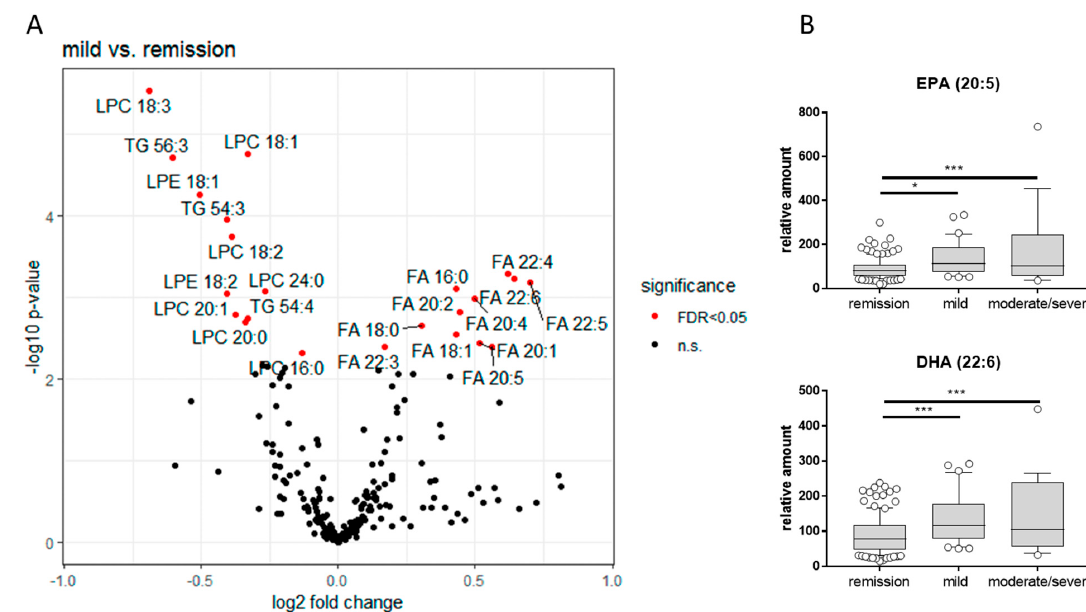
Figure 7. Lipids in human plasma. ( A ) Volcano blot of lipids in human plasma determined by LC-QTOFMS. Shown are the significances versus fold-changes of all lipids measured in plasma of UC patients who are in remission or suffer from mild disease. n remission = 109, n moderate = 33. Statistical analysis was performed with R, significant differences between groups were assessed using two-tailed ANOVA with Tukey multiple comparison, α = 0.05. ( B ) Relative amounts of EPA and DHA in plasma of UC patients with di ff erent disease stages. n remission = 109, n moderate = 33; n acute = 19. Statistical analysis was performed with GraphPad, significant di ff erences between groups were assessed using two-tailed ANOVA with Tukey multiple comparison, α = 0.05. (* p < 0.05, ** p < 0.01, *** p <